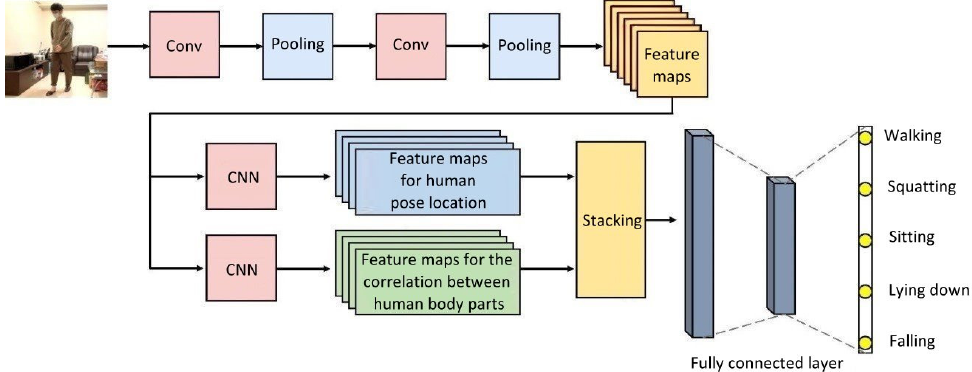
Figure 1. Common CNN architecture used in human pose image recognition.